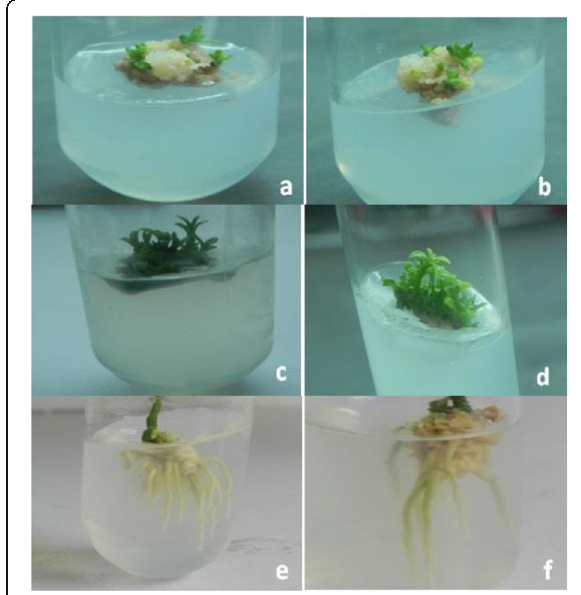
Fig. 7 Shoot and root induction from kanamycin resistant explants on MS medium of Citrus reticulata Blanco ( a , c , e ) and Citrus sinensis (L.) Osbeck ( b , d , f )